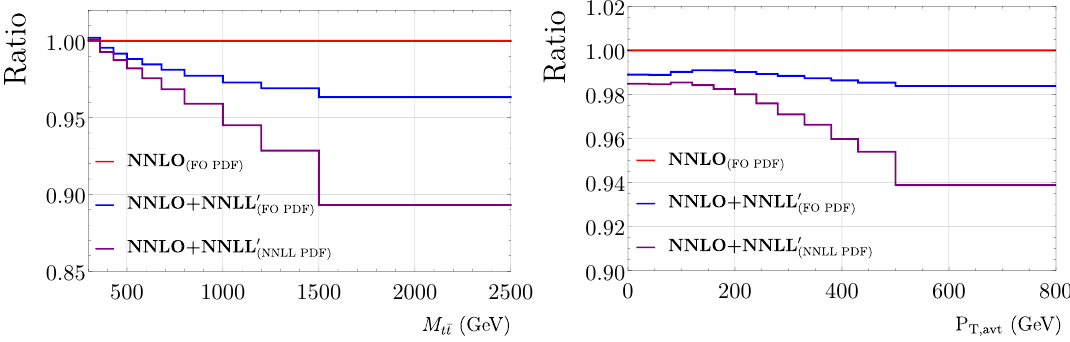
Figure 12 . Comparison of predictions obtained for the M and p T; avt distributions with regular t (cid:22) t and resummed PDFs. Plotted are the NNLO prediction (red) using a (cid:12)xed order PDF as well as the NNLO+NNLL 0 predictions computed both with (cid:12)xed order (blue) and NNLL threshold resummed PDFs (purple). Each distribution is normalized to the NNLO